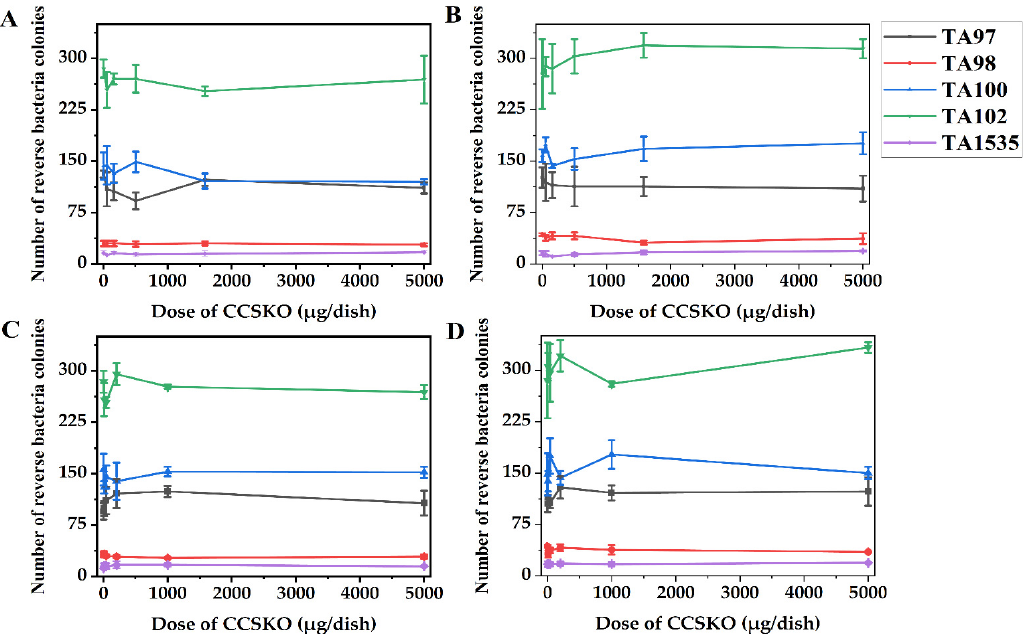
Figure 3. The relationship between the dose of CCSKO ( μ g/dish) and the number of reverse bacteria colonies in the experimental group. ( A ) The preliminary test in the absence of S9 ( − S9). ( B ) The pre- liminary test in the presence of S9 (+S9). ( C ) The main test in the absence of S9 ( − S9). ( D ) The main test in the presence of S9 (+S9). Data are expressed as mean ± SD.